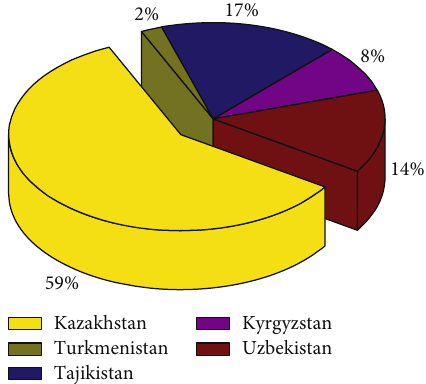
Figure 8: Distribution map of Chinese investment in Central Asian countries in